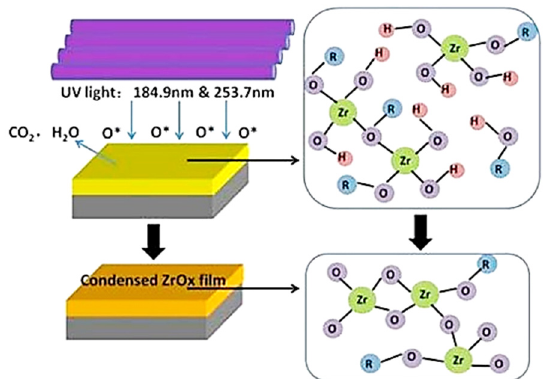
Figure 10. Schematic diagram of ZrAcAc sol–gel transformation mechanism under ultraviolet ozone (UVO) irradiation [92]. Reprinted with permission from [92]; 2017 Elsevier.